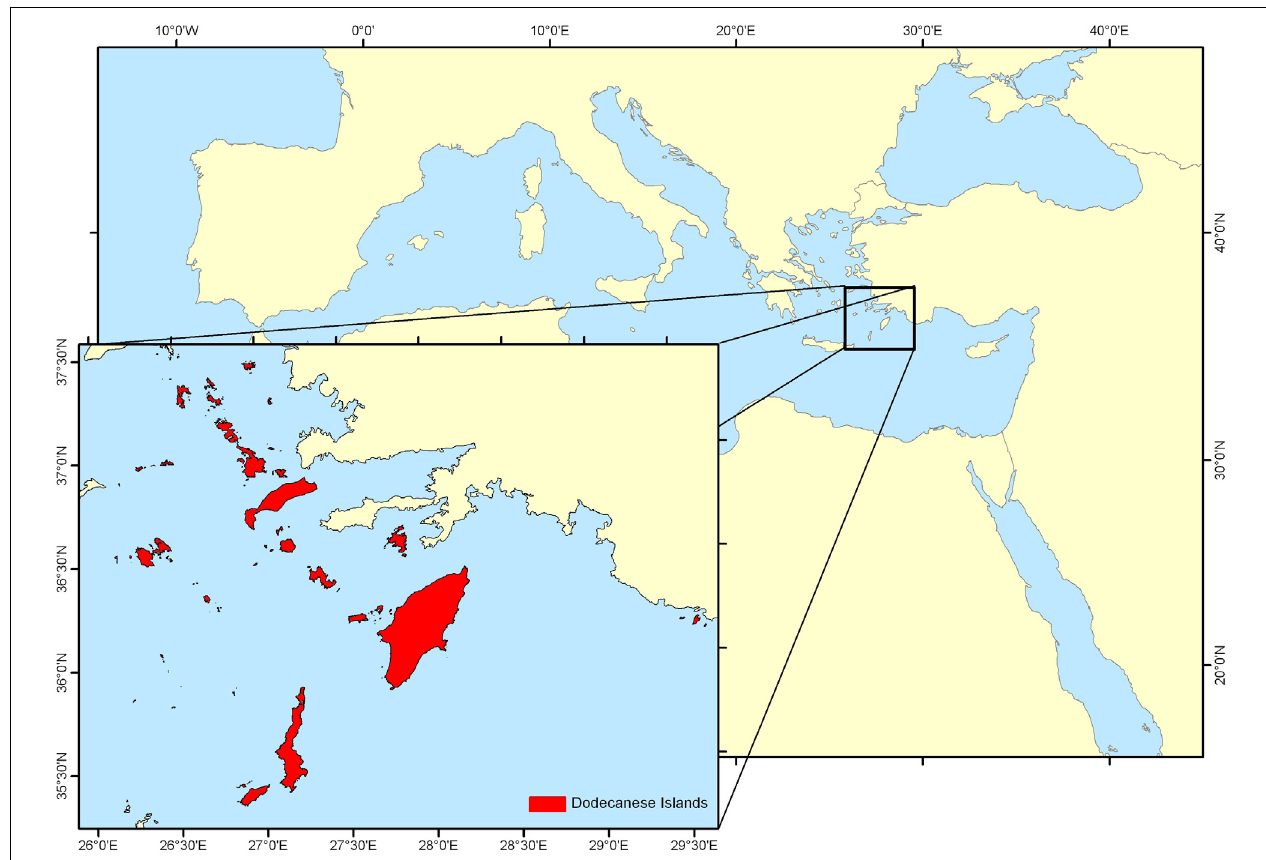
FIGURE 1 | Map of sampling area – Dodecanese Islands, southeastern Aegean Sea, eastern Mediterranean